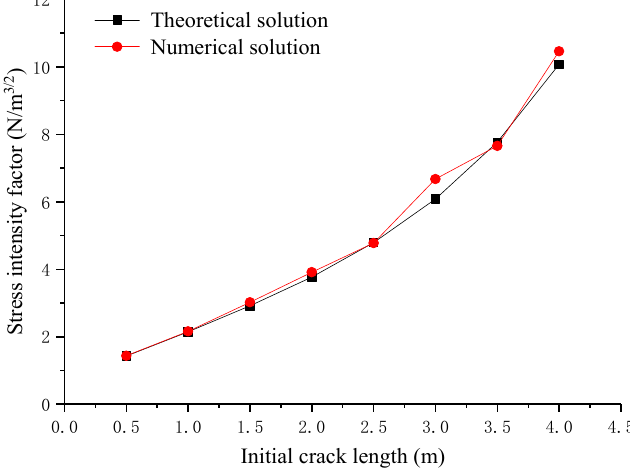
Figure 4. Stress intensity factors for different initial crack lengths.